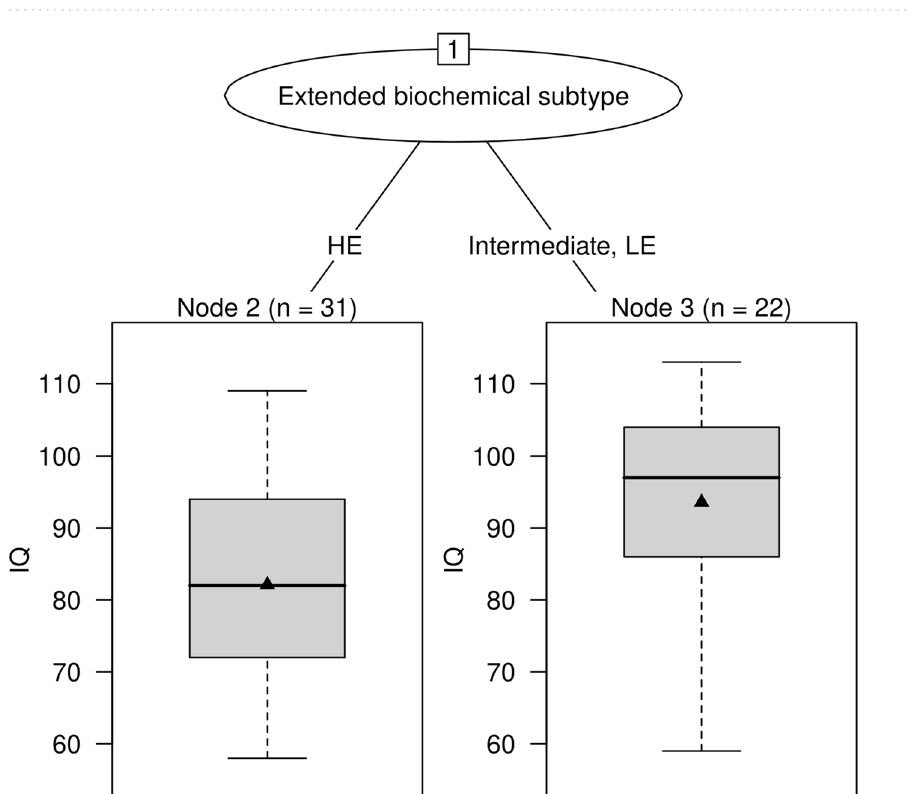
Figure 2. Extended biochemical subtype and full scale IQ. Patients with intermediate subtype had similar results as LE patients (p = 0.677). Results of these two groups (median [horizontal line in box] IQ 97; IQR 86–104) differed from HE patients (median [IQR] IQ 82 [72–94]; p = 0.005). Black triangles indicate mean IQ. HE high excreter, LE low